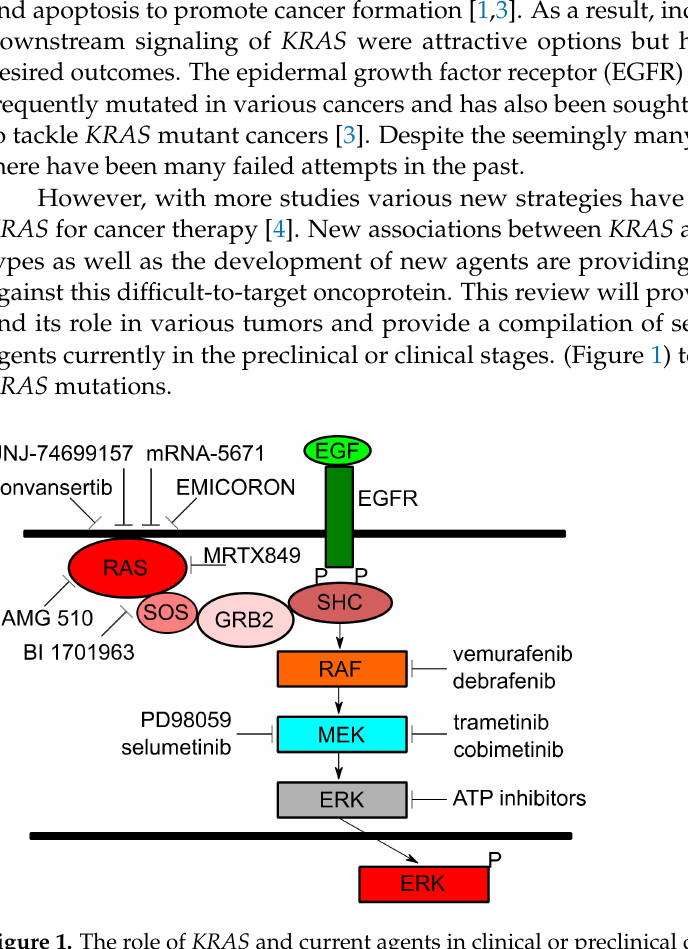
Figure 1. The role of KRAS and current agents in clinical or preclinical